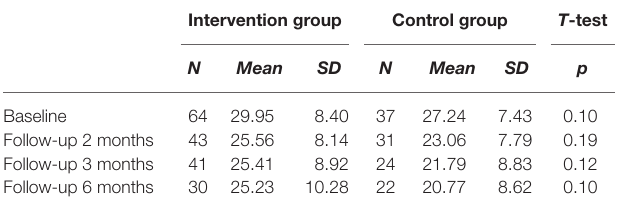
TABLE 2 | Life Style Index (LSI) total score at baseline and three follow-up time points. Intervention